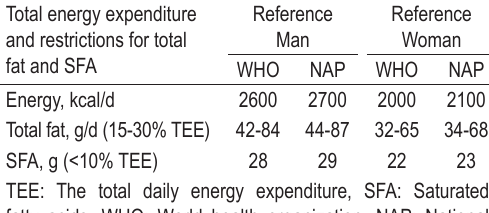
TABLE 1. Recommended restrictions of total fat and saturated fatty acids daily intake Total energy expenditure and restrictions for total